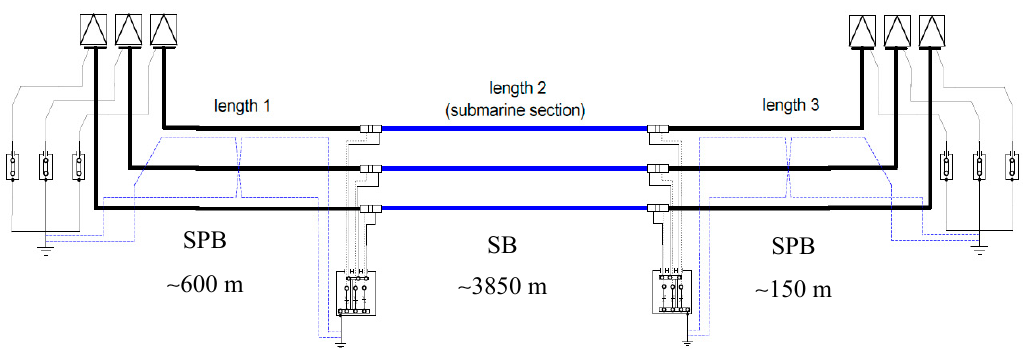
Figure 2. Screen bonding arrangements for the Lâpseki–Sütlüce I cable system.